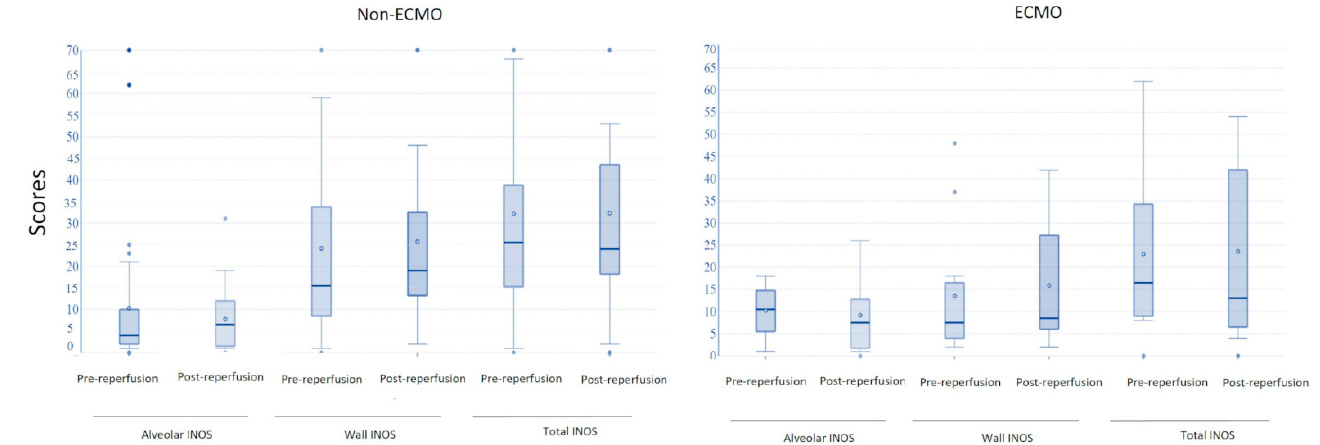
Figure 7. Comparison of pre- and post- reperfusion biopsies for alveolar, wall, and total INOS in non-ECMO and ECMO patients showing the tendency of iNOS values to increase in post-reperfusion biopsies of non-ECMO patients. Table 3. Donor histological findings: descriptive statistics. Continuous data are reported as medians (I, III quartiles); categorical data are reported as percentages and absolute frequencies. Wilcoxon- type tests were performed for continuous variables, and Pearson chi-square tests were performed for categorical variables.